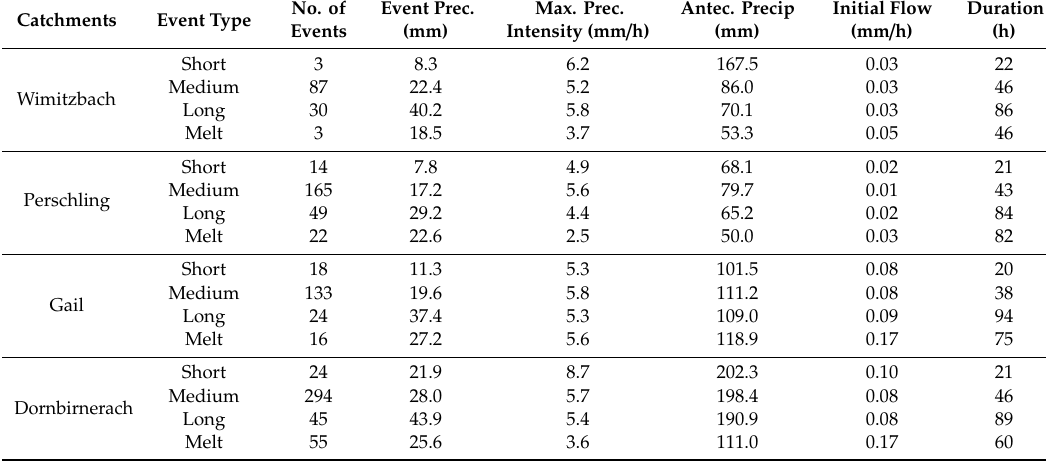
Figure 9. Variability of runoff coefficient, recession time constant, and event peaks for four types of runoff events. The type of runoff event is defined by its duration, i.e., short (duration less than 24 h), medium (duration between 24 and 72 h), long (duration more than 72 h). Events with the contribution of snowmelt are classified as melt events. Table 4. Summary of event and median values of their characteristics (median values) grouped according to four event types: short (duration less than 24 h), medium (duration between 24 and 72 h), long (duration more than 72 h), and snowmelt (having a contribution from snowmelt).